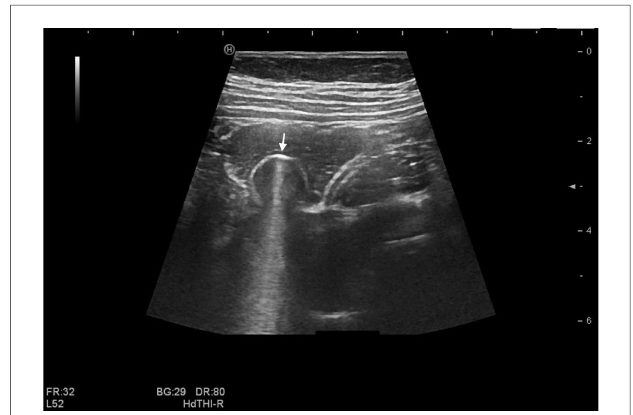
FIGURE 3 Single magnet in the gastrointestinal tract of a 2-year-old boy. A strong arc-shaped echo with a comet tail sign (white arrow) is seen in the ascending colon, with a diameter of 1.2 cm.